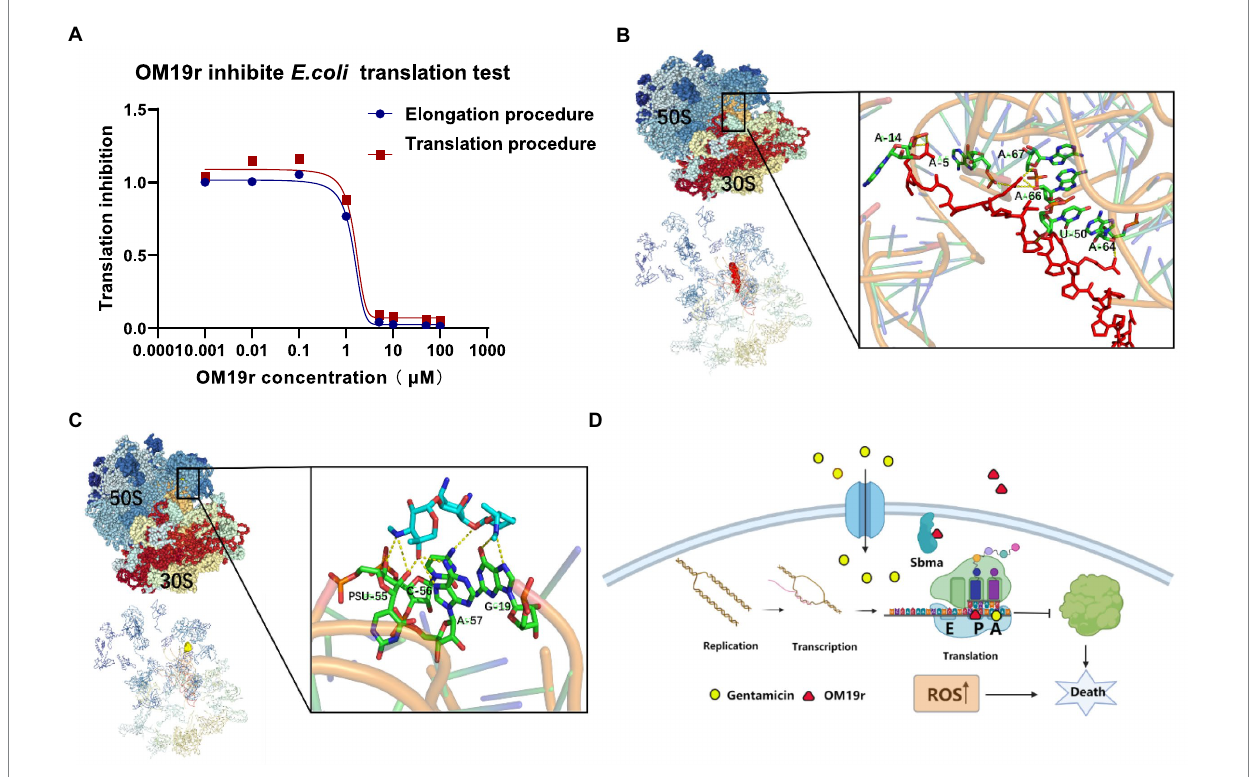
FIGURE 12 Translation elongation process of OM19r-targeted mRNA. (A) Dose–response of OM19r inhibition mRNA translation (red) and fMet-Phe dipeptide formation (blue) in vitro . (B) Molecular docking results of OM19r and ribosome. (C) Molecular docking results of GEN and ribosome. (D) Schematic diagram of synergistic antibacterial action mechanism of OM19r combined with